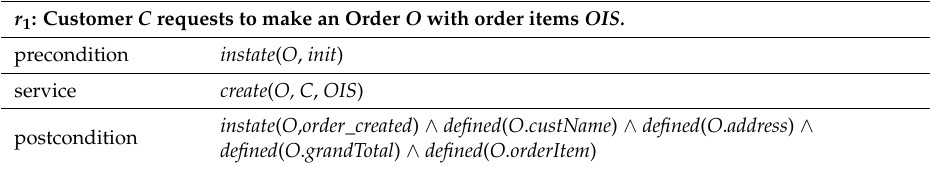
Table 1. An example of business rules in the purchase process (Figure 1).